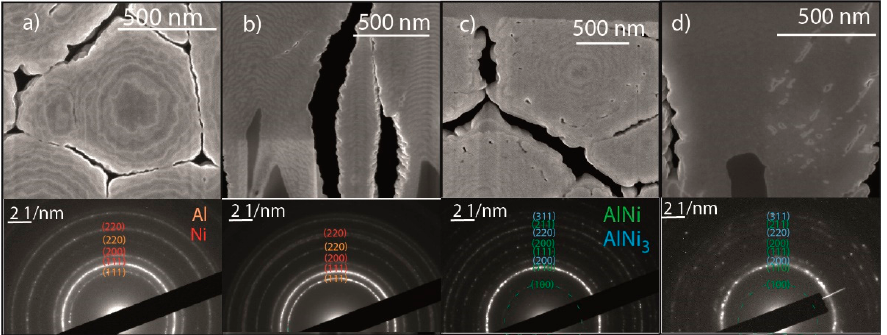
Figure 7. Scanning electron microscope of the 3D-RMS in a cross-section view for the as-deposited RMS ( a , b ) and after treatment with the RTA ( c , d ) up to 550 ◦ C (the images were taken at the following tilt angles: ( a ) at 0 ◦ , ( b – d ) at 51 ◦ and ( c ) at 53 ◦ ). The insets display the diffraction contrast images of the respective picture ( a – d ). The diffraction rings are indexed to certain planes and phases in every inset.